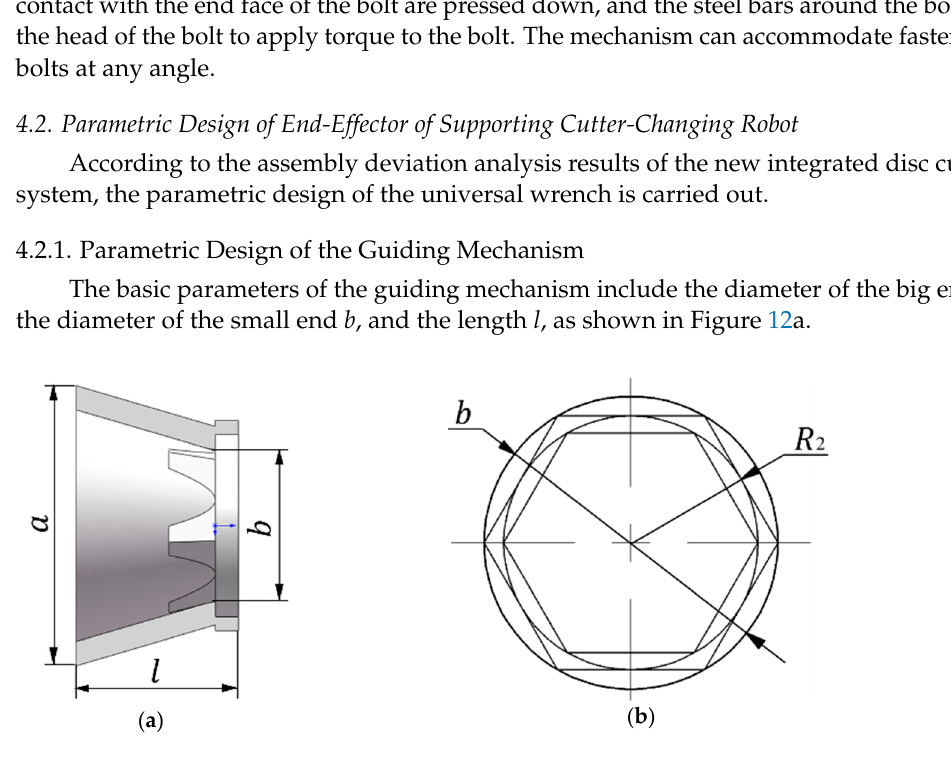
Figure 12. Parametric design of the guiding mechanism. ( a ) Parameters of the guiding mechanism. ( b ) Diameter of the guiding mechanism’s small end. (1) The diameter of the big end a